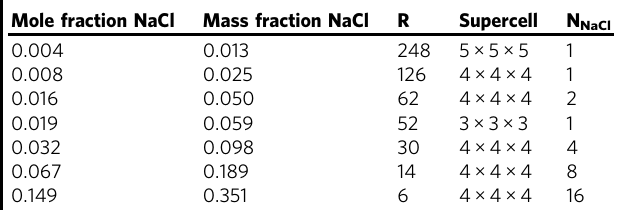
Table 1 The equivalence between mole% and wt% for the various NaCl-bearing H 2 O terms used in the simulations denoted as NaCl· R H 2 O